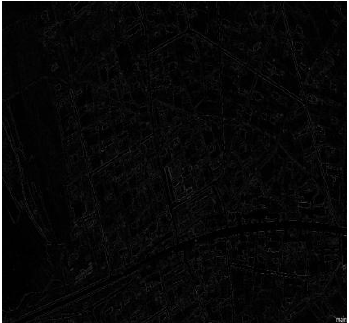
Figure 2. canny edge detection (partial)